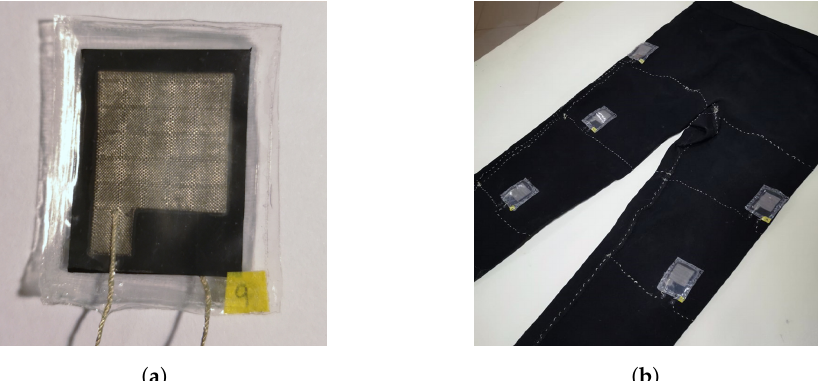
Figure 1. ( a ) Sample of the textile pressure sensors manufactured in the laboratory; ( b ) Textile pressure sensors attached to the expandable fabric